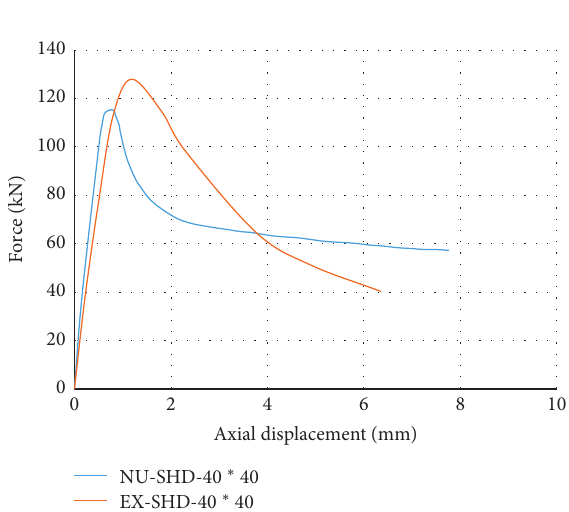
Figure 4: Force-displacement diagram of model and laboratory sample